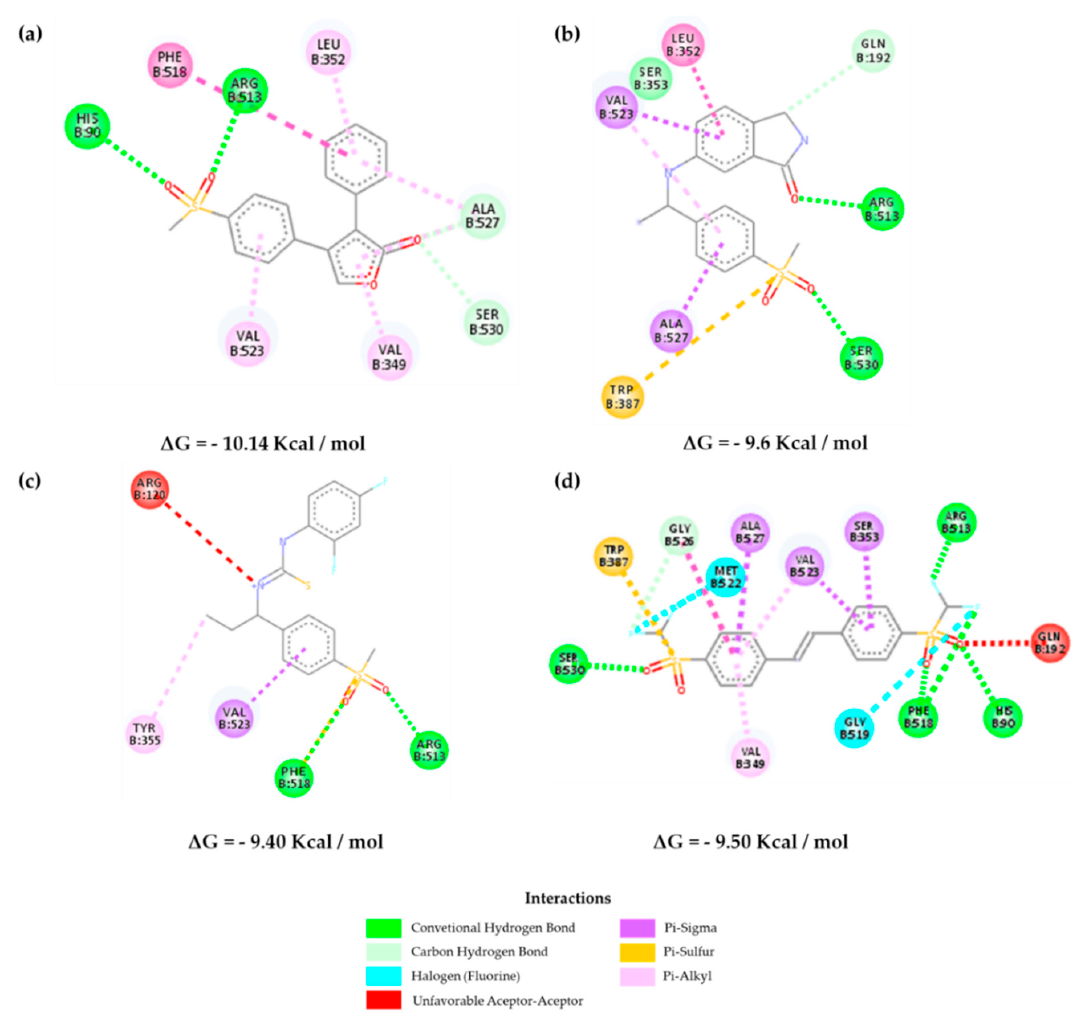
Figure 7. Interactions of the inhibitors ( a ) rofecoxib, ( b ) Z-627 , ( c ) Z-964, and ( d) Z-814 with the active